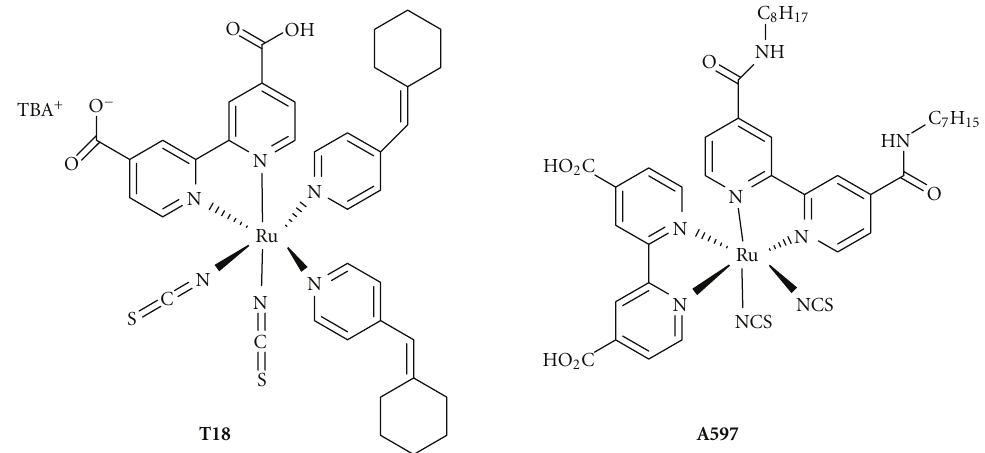
Figure 29: Molecular structures of T18 (taken from [49]) and A597 (taken from